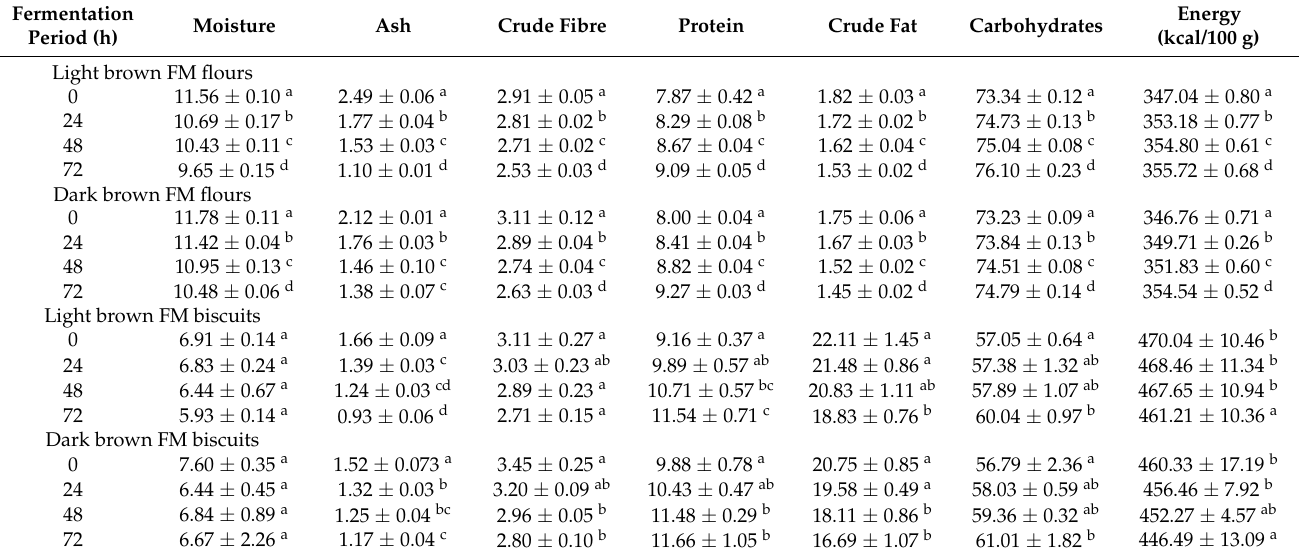
Table 1. Effect of fermentation time on the proximate composition of finger millet flours and biscuits (% dry